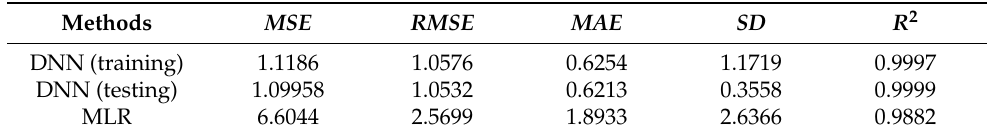
Table 4. The performance measures of DNN and MLR.